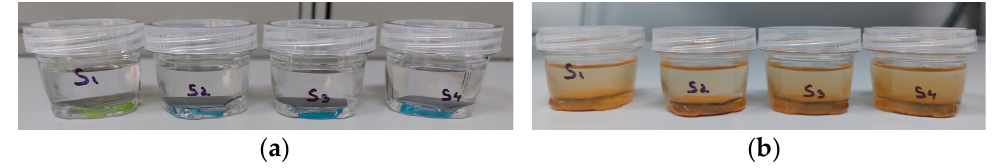
Figure 2. Images of S235JR steel samples for (S1)—S235JR—non-sandblasted, (S2)—S235JR—sandblasted with quartz, (S3)—S235JR—sandblasted with garnet, (S4)—S235JR—sandblasted with alumina: ( a ) at T 1 = at immersion, ( b ) T 2 = after 336 h from immersion time. After weighing, weight loss was evaluated using ASTM G1 ‐ 90 (1999) with Equations (3) and (4) below, respectively [30,31]: